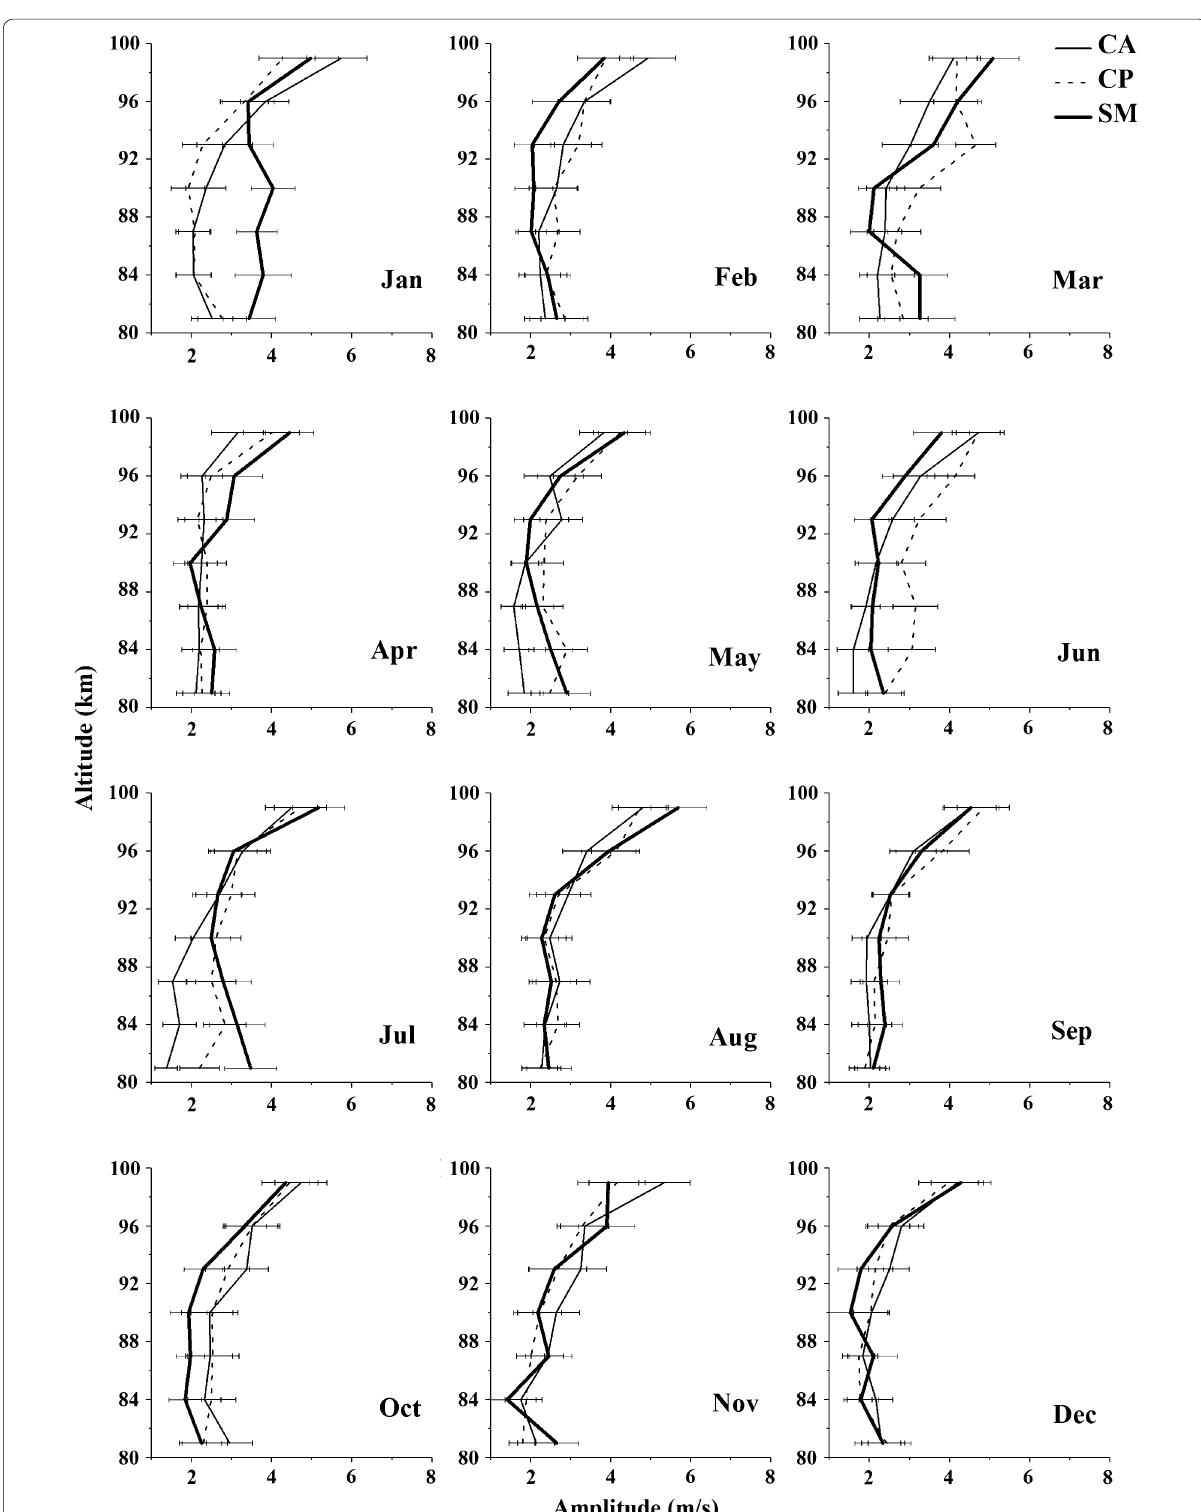
Fig. 6 Monthly mean amplitude of the QDT in the MLT at CA (thin line), CP (dotted line) and SM (bold line) over various months of the year in the zonal wind. The horizontal bars represent the